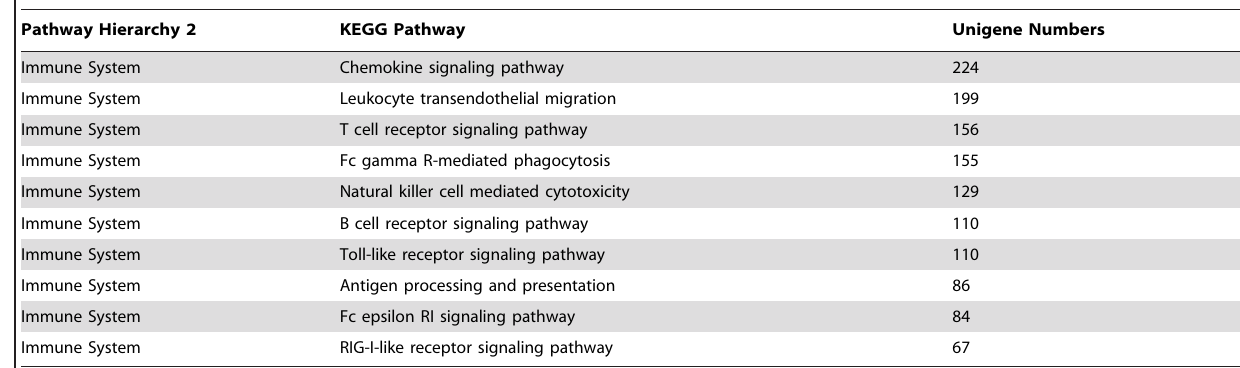
Table 4. Top 10 list of pathways related to immune system.